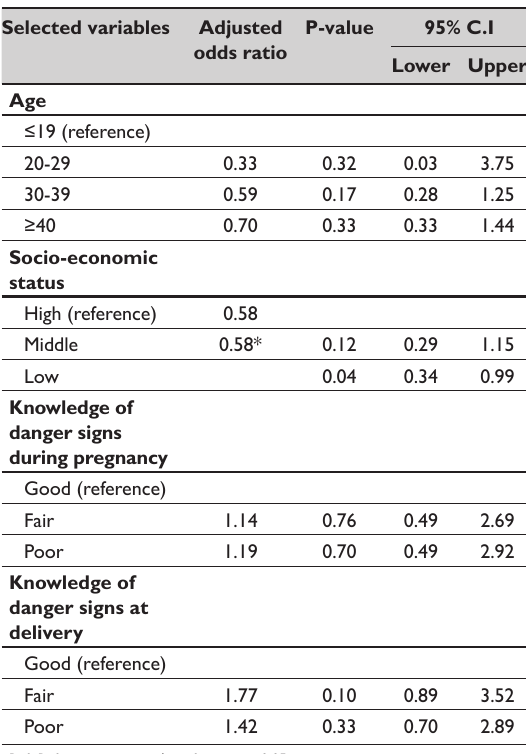
Table 3. Predictors of Respondents’ Birth Preparedness and Complication